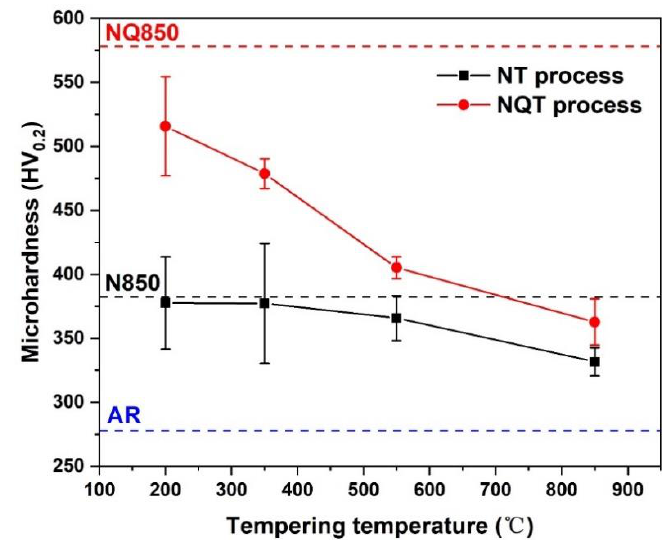
Figure 9. Variation of microhardness under different tempering states.